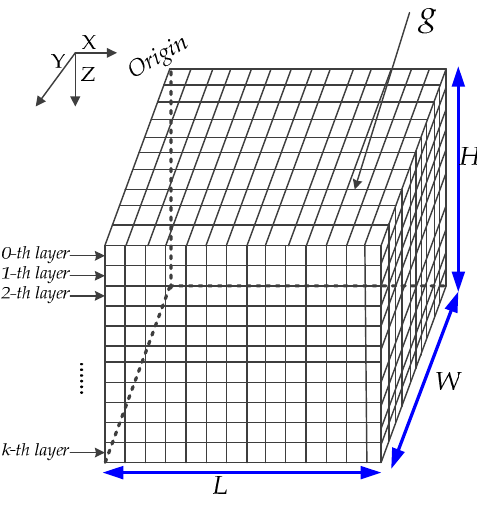
Figure 2. Grid division for 3D UWSNs.